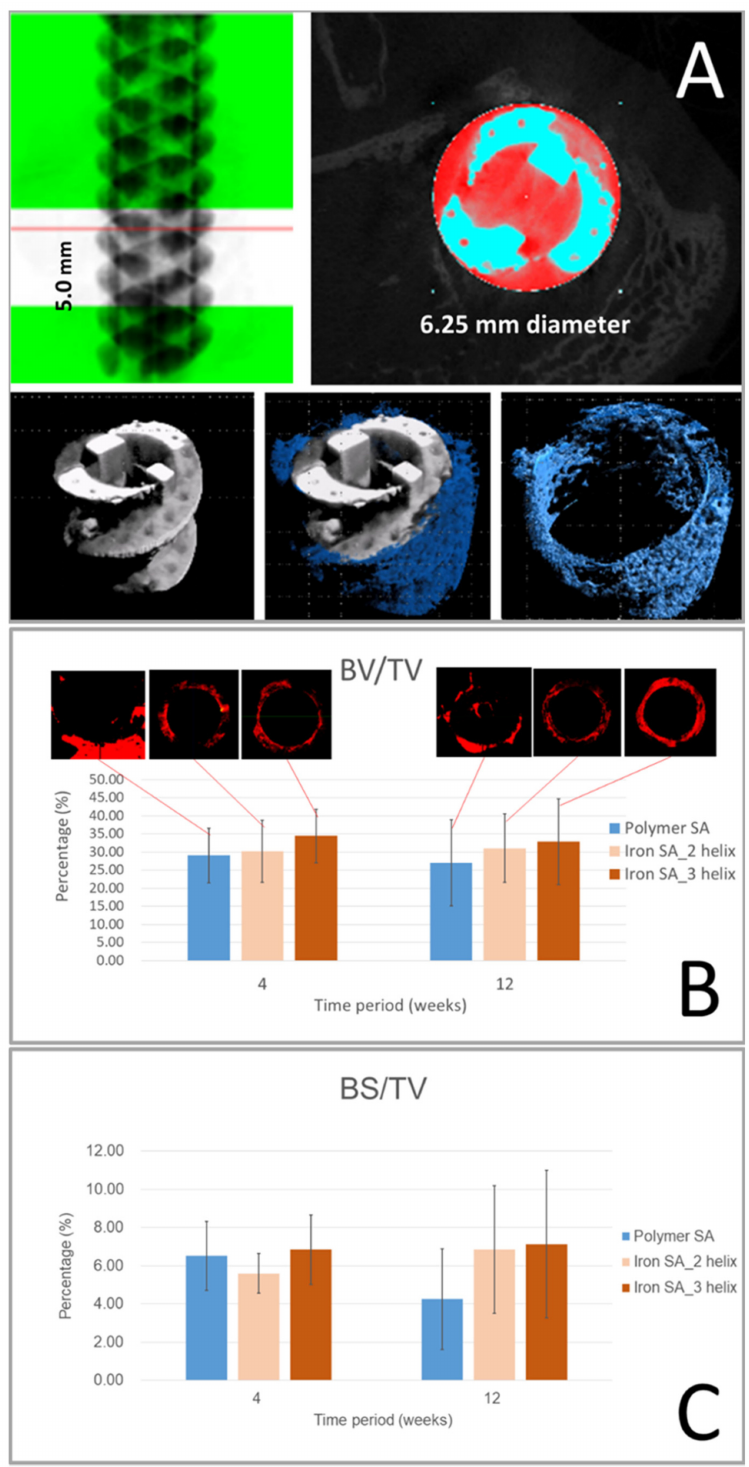
Figure 4. Micro-computed tomography (Micro-CT) analysis. The region of interest (ROI; diameter, 6.25 mm; thickness, 5 mm) of the bone–implant block was segmented before bone analysis, and bone growth was examined 0–1000 µ m around the implant ( A ). Quantitative evaluation of bone volume between bone and suture anchors. Tissue volume (TV, mm3), bone volume (BV, mm3), and bone surface (BS, mm2) were examined 0–1000 µ m above the implant surface. Bone volume fraction (BV/TV) ( B ) and bone surface density (BS/TV) ( C ) represent the bone volume rate and bone tissue surface rate, respectively. The error bar represents the standard